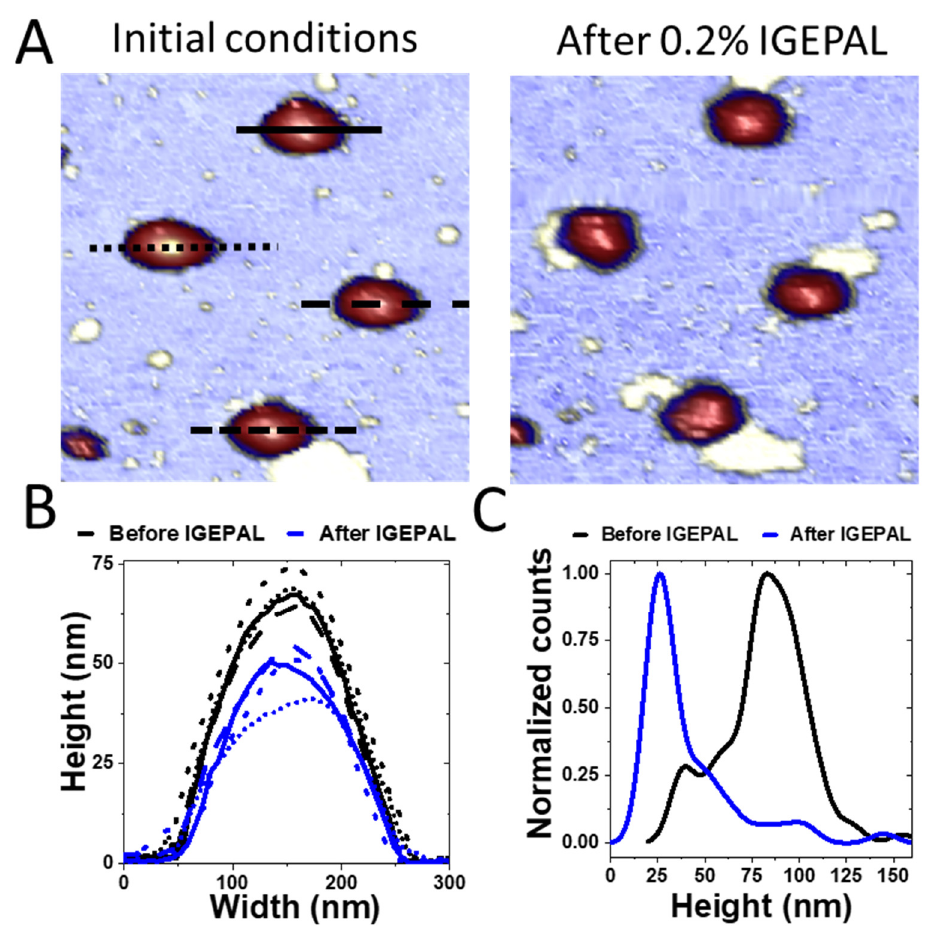
Figure 3. Treatment of TGEV with IGEPAL 0.2% ( A ). Topographical images before (left) and after (right) IGEPAL treatment ( B ). Profiles traced over the particles before (black) and after (blue) the treatment. The time interval between images was ~30 s ( C ). Height distribution of TGEV particles before (black) and after (blue) treatment ( n = 103). Counts taken from the distribution curve were normalized for comparison. The peak shifts from the value of the intact particle height to the height of the